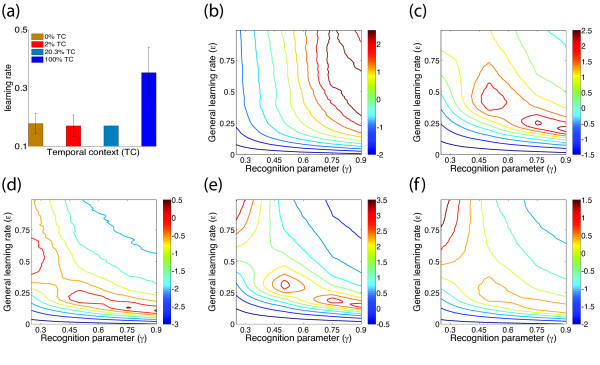
Actual learning rates and estimated parameters. (a) Acceleration of learning during the initial appearance of objects due to different degrees of temporal context. In the presence of a fully predictive temporal context, the accumulation of information was accelerated by 0.13 bit. Error bars in Figure 3a show the standard deviation across experiments for each object type. Plots (b)-(f) show regions of optimal values in the parameter space (ϵ, γ), corresponding to the general learning rate and the recognition parameter, respectively. The color scales to the right of each plot refer to the fit quality fQ for each parameter pair (ϵ, γ), which was computed as , where  and  are the mean values of performance correct in the i-th appearance for human observers and for the model simulations, respectively, and  and  are the corresponding standard deviations. The higher the fQ values, the better the fit between measured and predicted data.